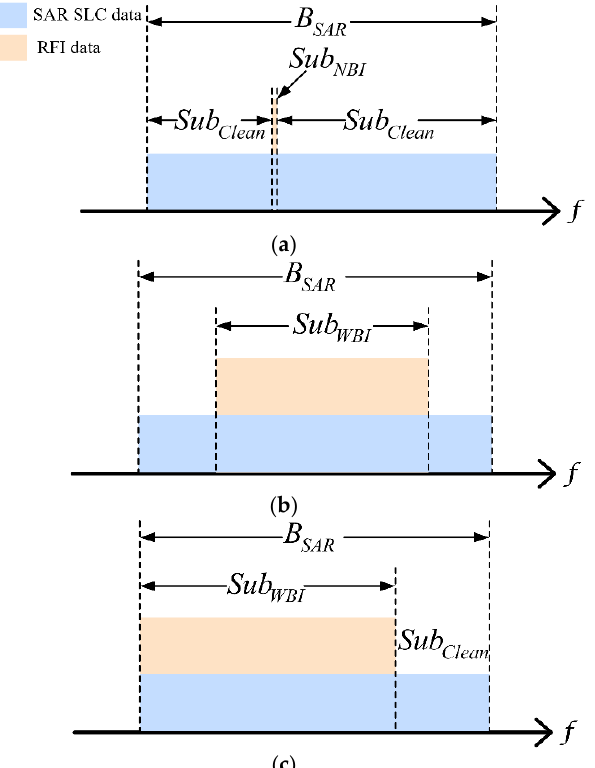
Figure 4. The schematic diagram of subband division. ( a ) Subband division of NBI. ( b , c ) Subband division of WBI.